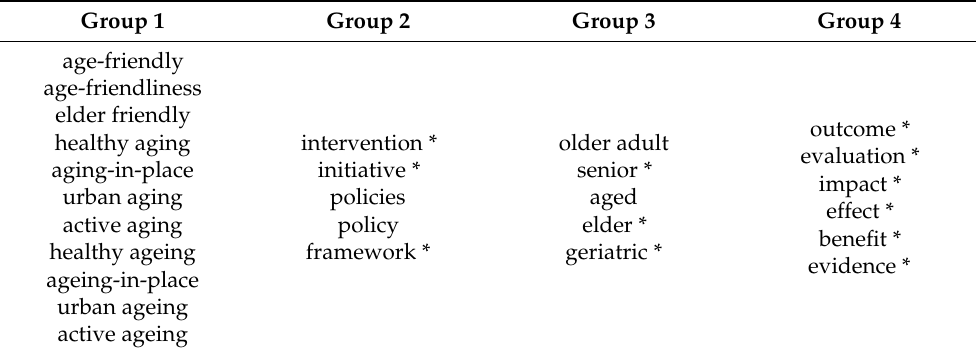
Table 1. Search term